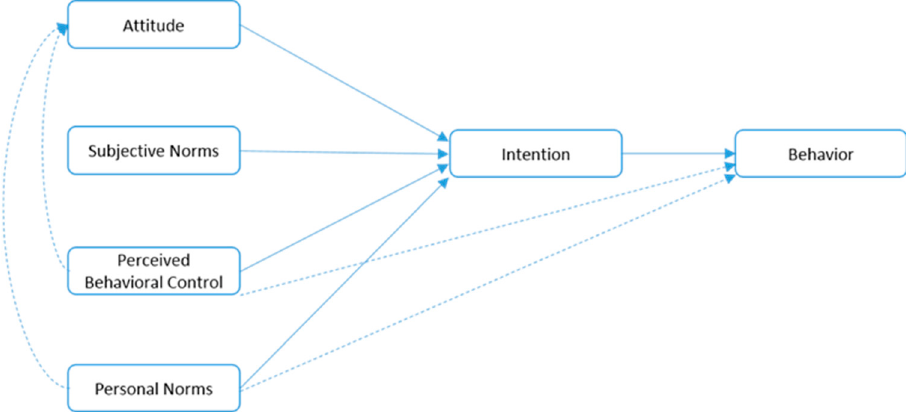
Figure 1. Theory of planned behavior (TPB) framework adapted from Ajzen and Harland et al.